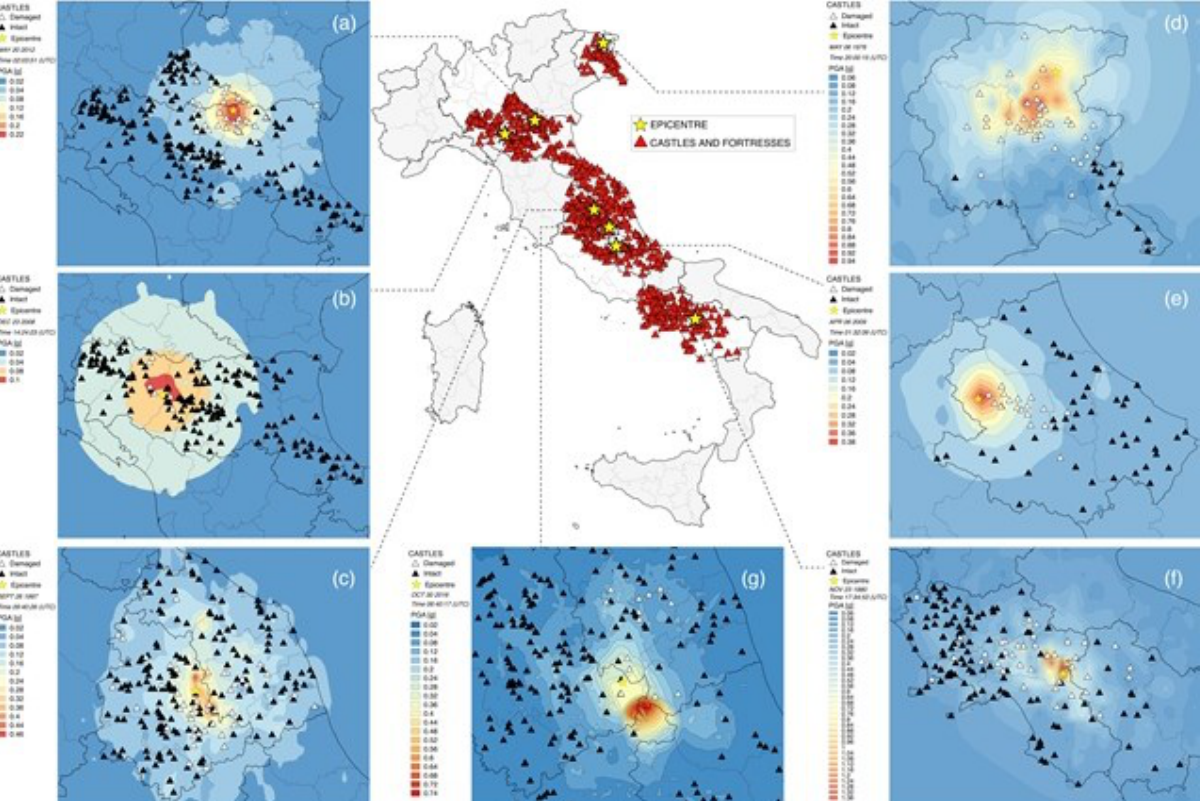
Figure 4. Map of Italy with the investigated fortified buildings. The map is surrounded by the shakemaps (pga) of the main seismic